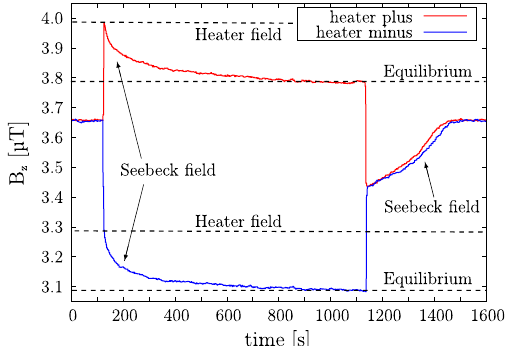
8. Release of different trapped fields during warm-up for a single crystal sample with 1200 (cid:1) C tempering.